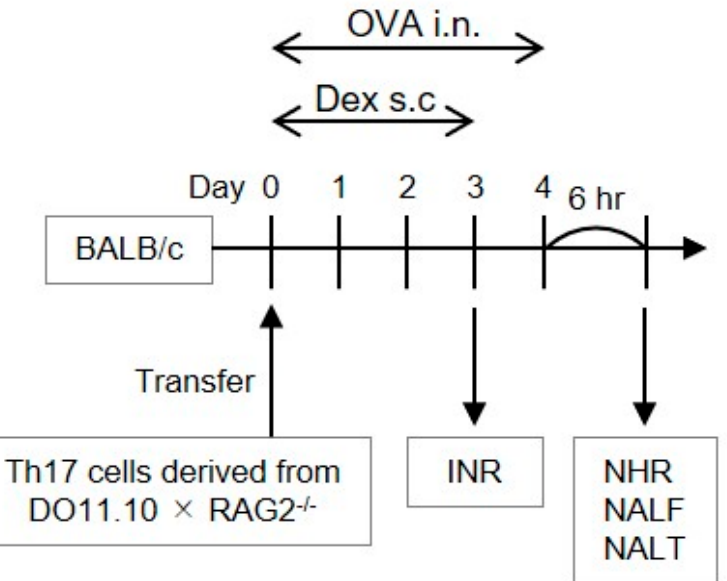
Figure 1. Procedural overview of the experiments. BALB/c mice infused with Th17 cells differentiated in vitro were challenged by intranasal (i.n.) ovalbumin (OVA, 600 µ g/head) injection once daily on days 0–4. Before challenge on days 0–3, they received dexamethasone (Dex, 2.5 or 10 mg/kg) through a subcutaneous route. Immediately after the OVA injection on day 3, immediate nasal response (INR) was assessed. Six hours following the last OVA injection on day 4, nasal hyperresponsiveness (NHR), nasal lavage fluid (NALF), and nasal-associated lymphoid tissue (NALT) were as- sessed.